Question: Looking at the figure, what chart type is it?
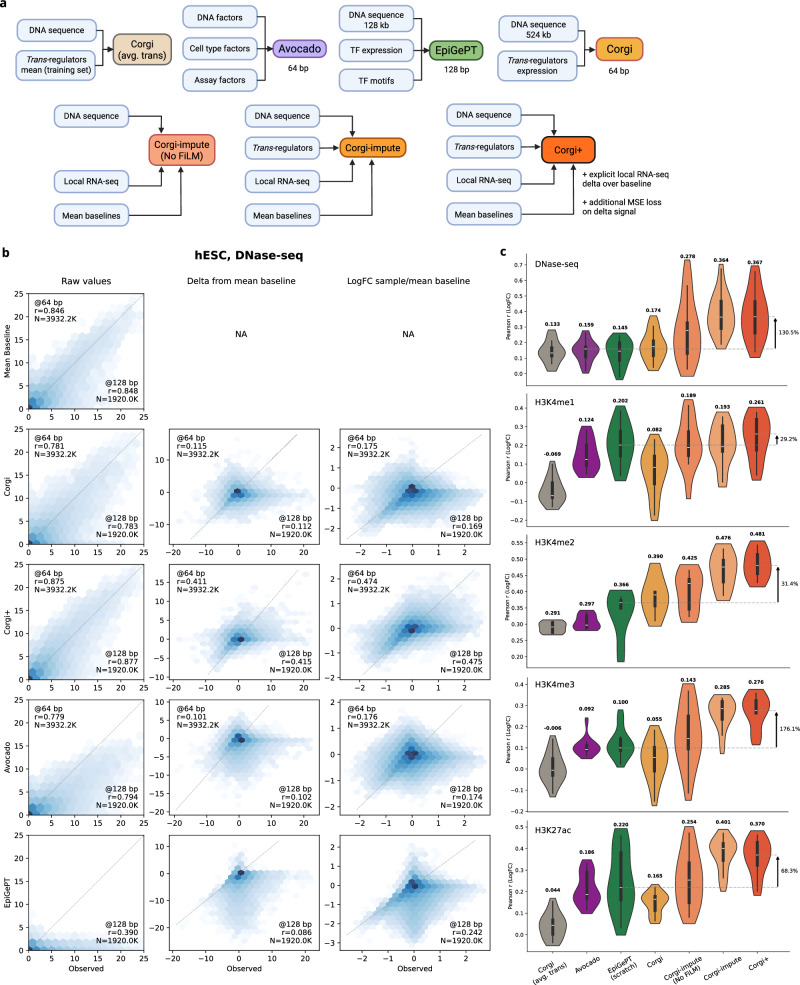
Answer: box